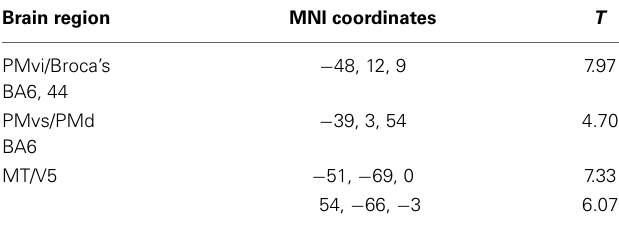
Brain activity is thresholded using a false discovery rate FDR correction for multiple comparisons across the entire volume at pFDR < 0.05 for the Visual Only VO contrast. BA, Brodmann area; PMvi, Premotor ventral inferior; PMvs, Premotor ventral superior; PMd, Premotor dorsal; MT, Middle Temporal Gyrus; V5, Visual Area 5. Negative x MNI coordinates denote left hemisphere and positive x values denote right hemisphere activity.